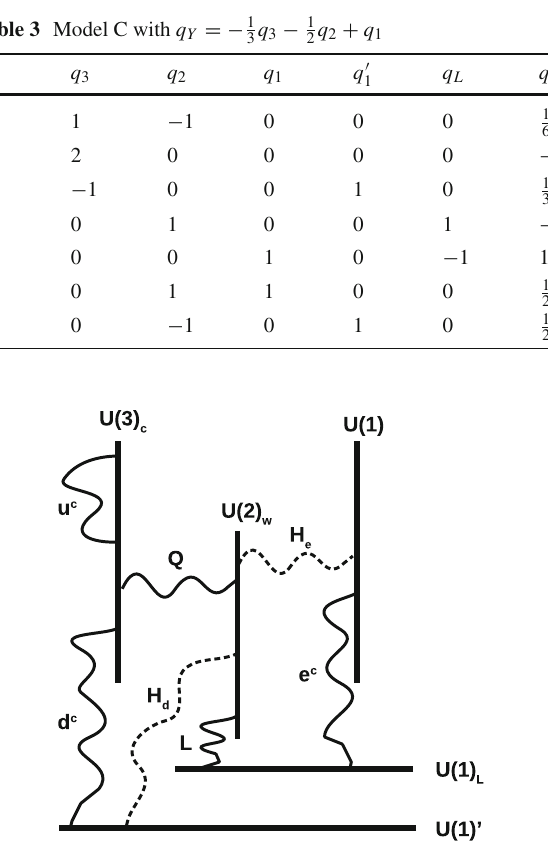
Fig. 2 Pictorial representation of model C